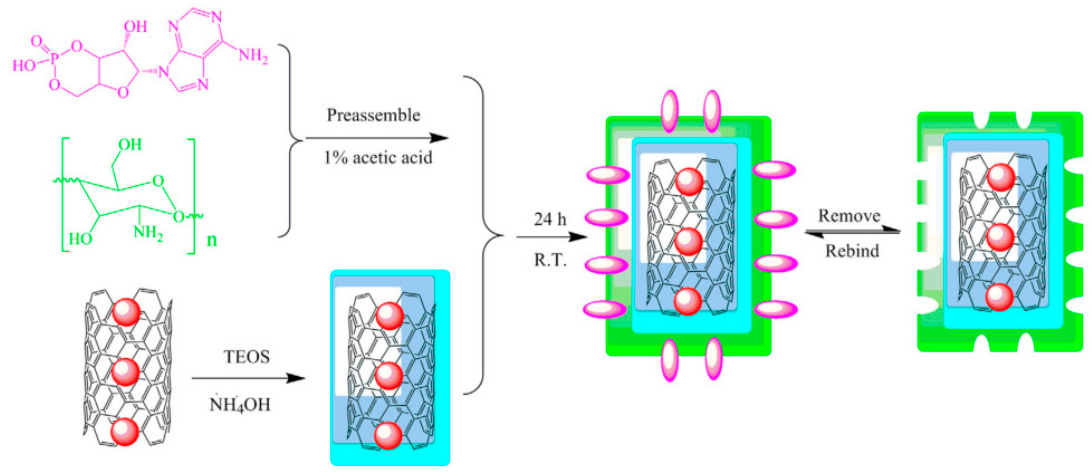
Figure 14. The synthesis procedure of cAMP-MIPs@MCNTs. Reprinted with permission from Ref. [112]. Copyright (2021) Weinheim.